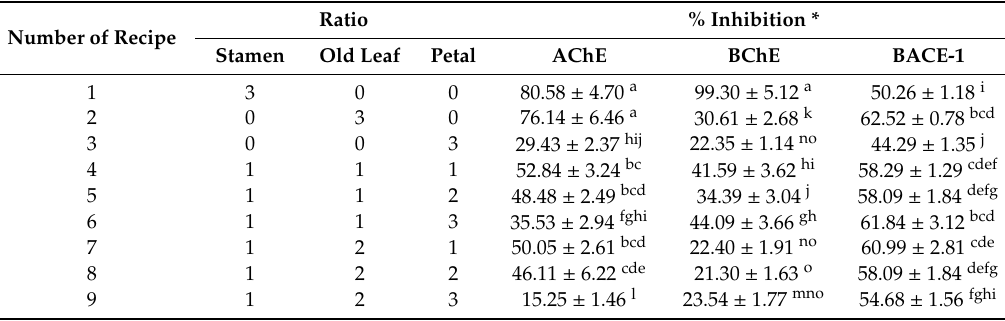
Table 8. Inhibitory activities against acetylcholinesterase (AChE), butyrylcholinesterase (BChE) and beta-secretase (BACE-1) of di ff erent mixtures (ratios) of stamen, old leaf, and petal of sacred